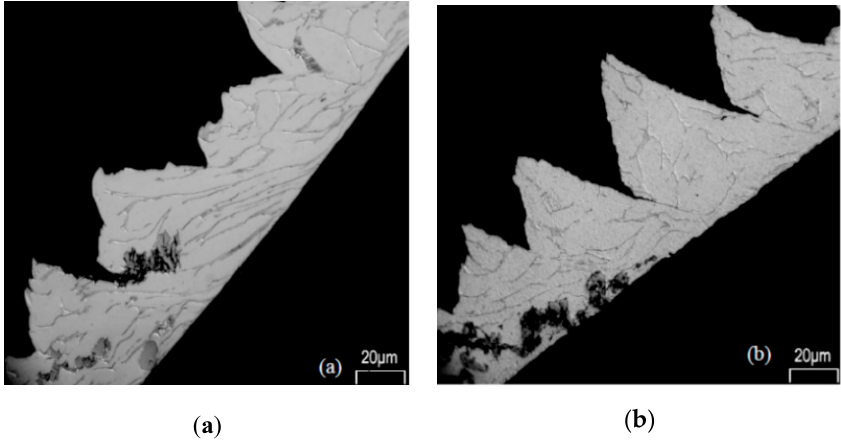
Figure 2. Chip microstructure with the polycrystalline diamond (PCD) tool at ( a ) 100 m/min; and ( b ) 230 m/min [32].